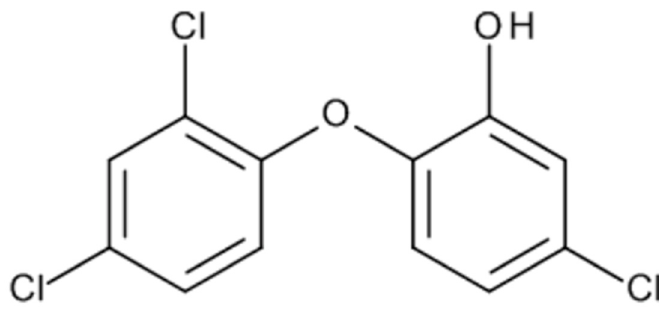
Figure 5. Chemical structure of Triclosan.